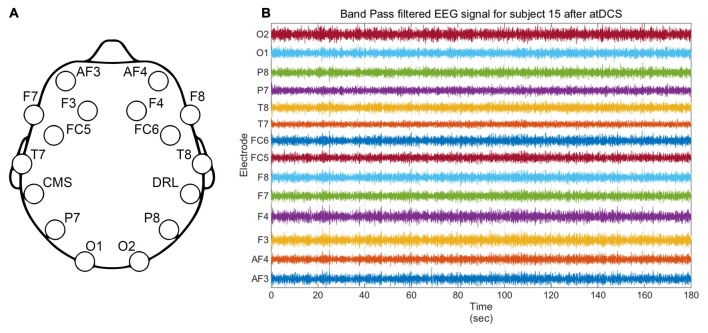
(A) Emotiv Epoc EEG headset electrodes location. CMS and DRL respectively stand for Common Mode Sense and Driven Right Leg and are used for reference and noise cancellation. (B) Illustrative filtered EEG signal from all electrodes for subject 15 for the active stimulation condition.